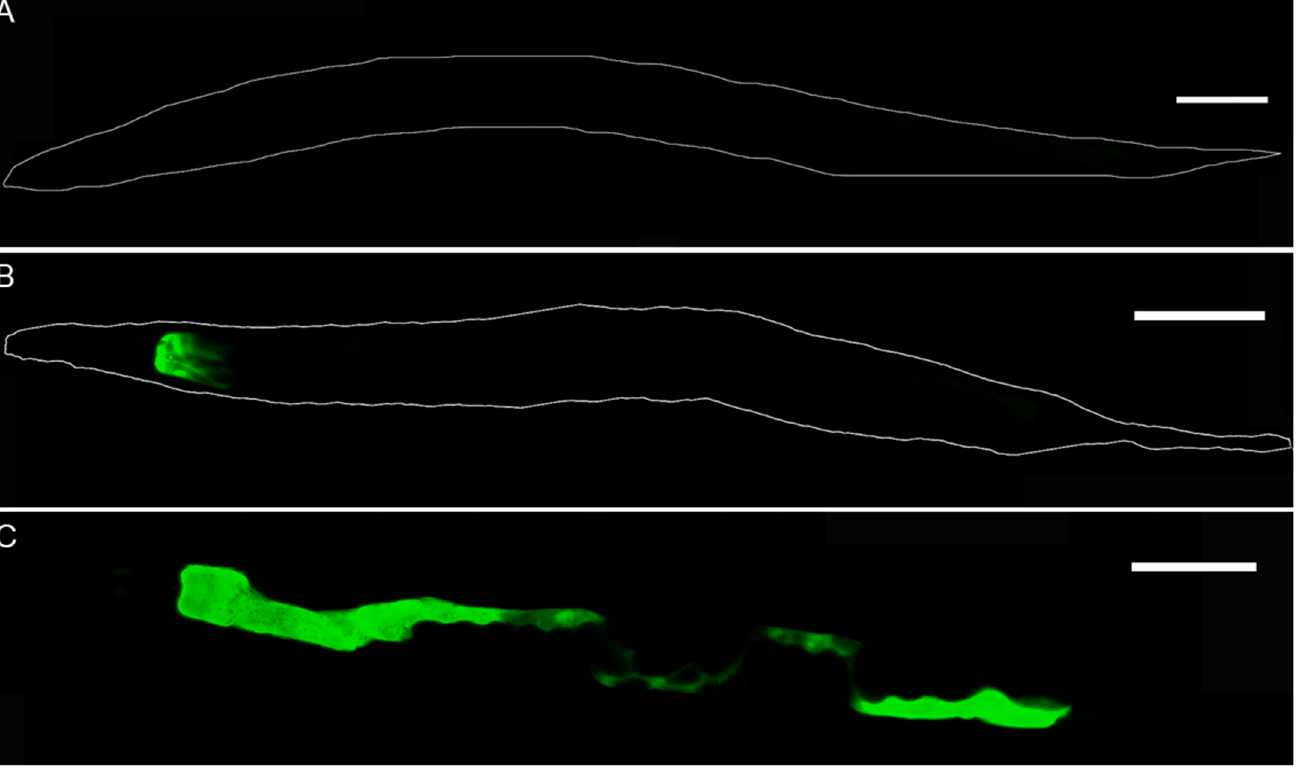
PLOS ONE | https://doi.org/10.1371/journal.pone.0184656 September 19,